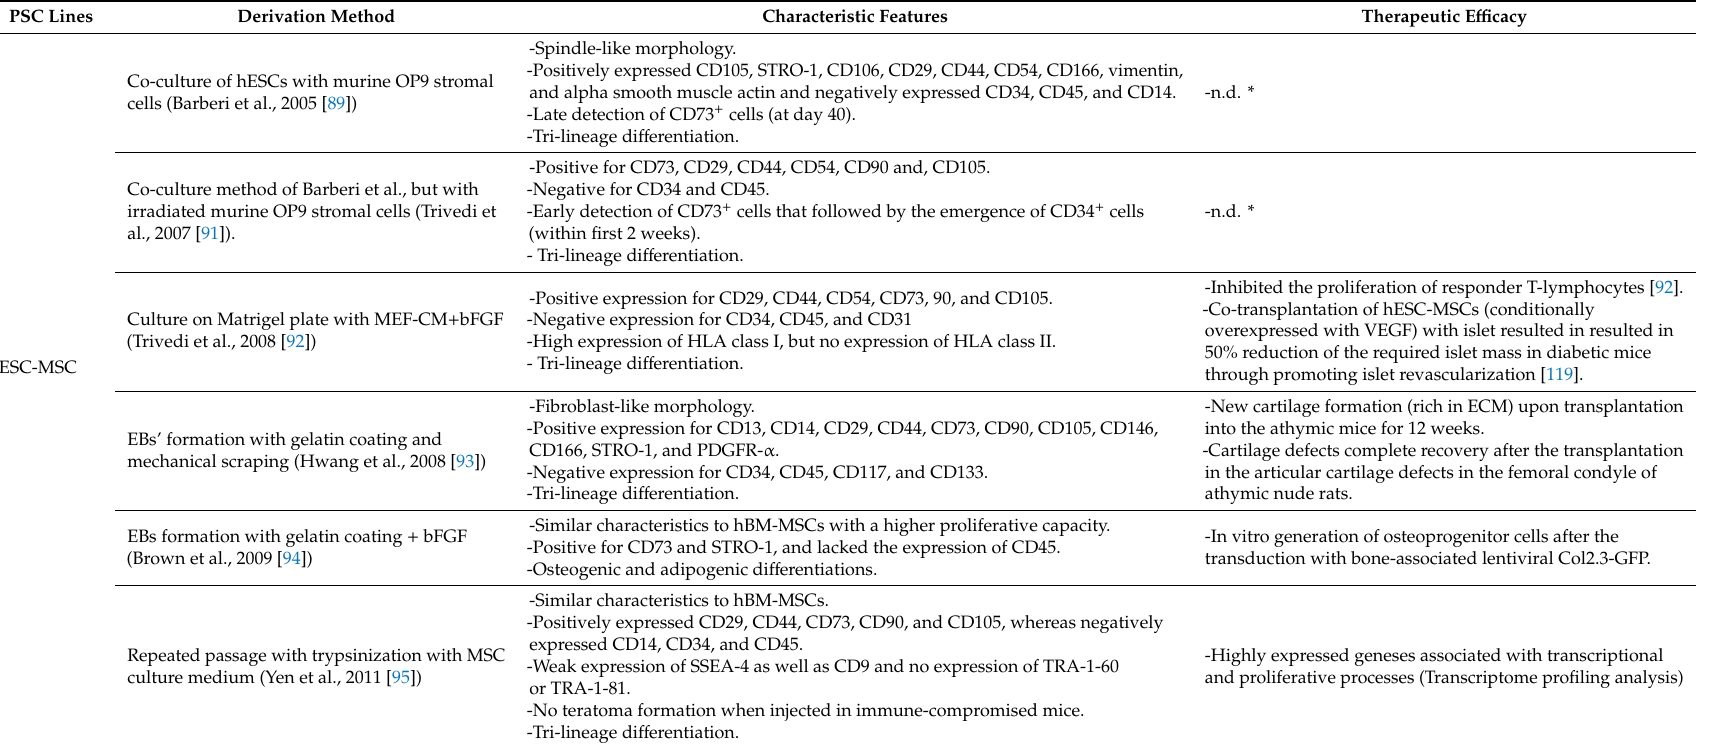
Table 1. Generation methods and the therapeutic e ffi cacies of pluripotent stem cells-derived mesenchymal stem cells (PSC-MSCs). SCID—severely